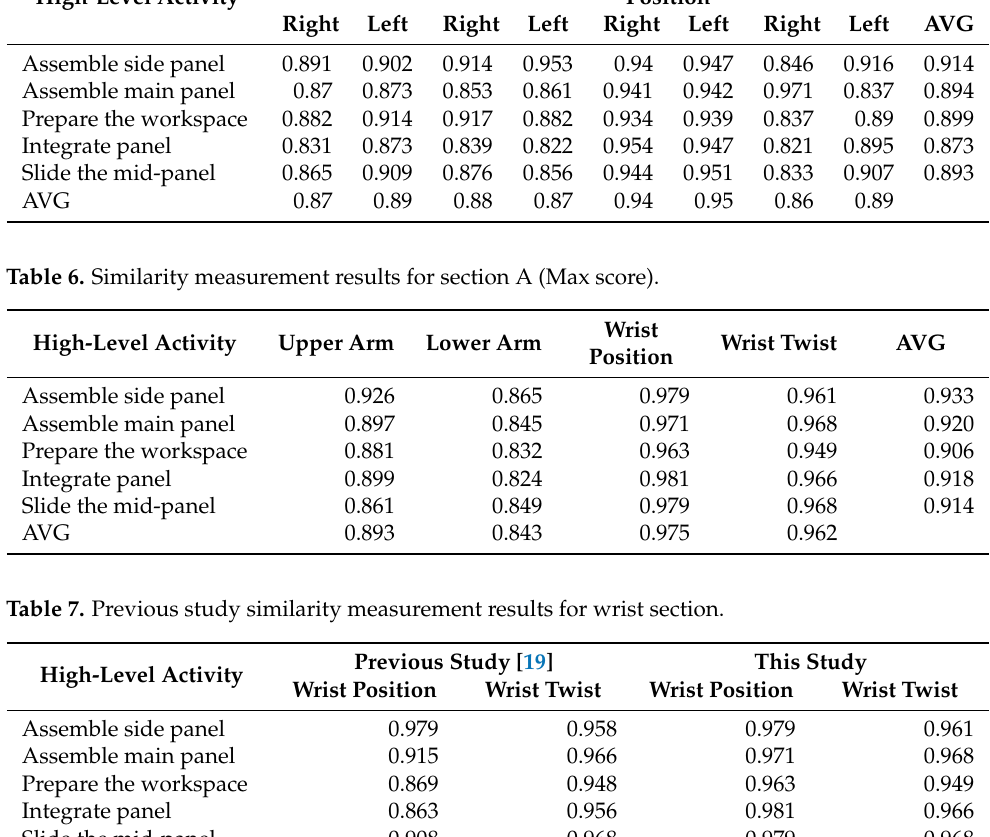
Table 5. Similarity measurement results for section A (right and left).